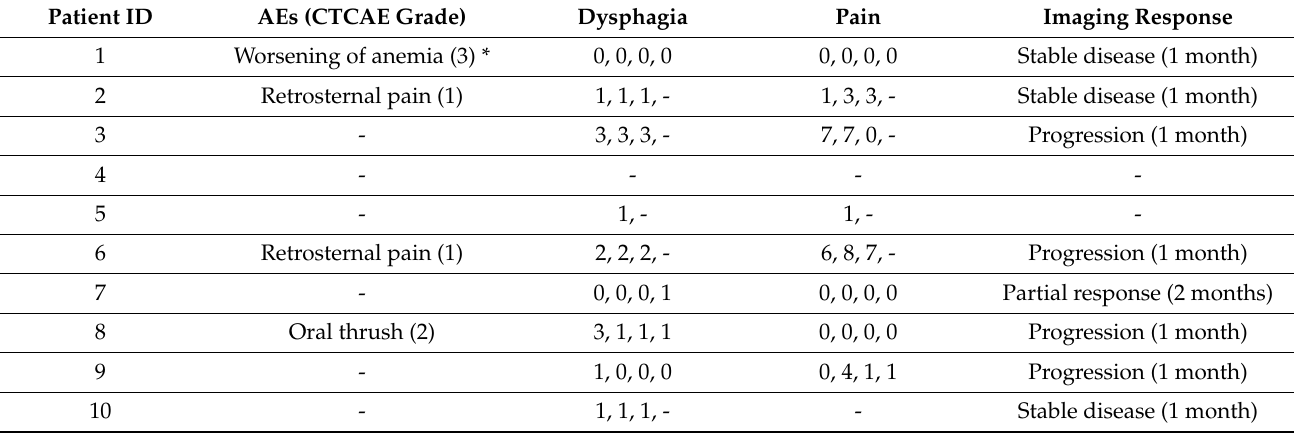
Table 2. Primary and secondary endpoints,